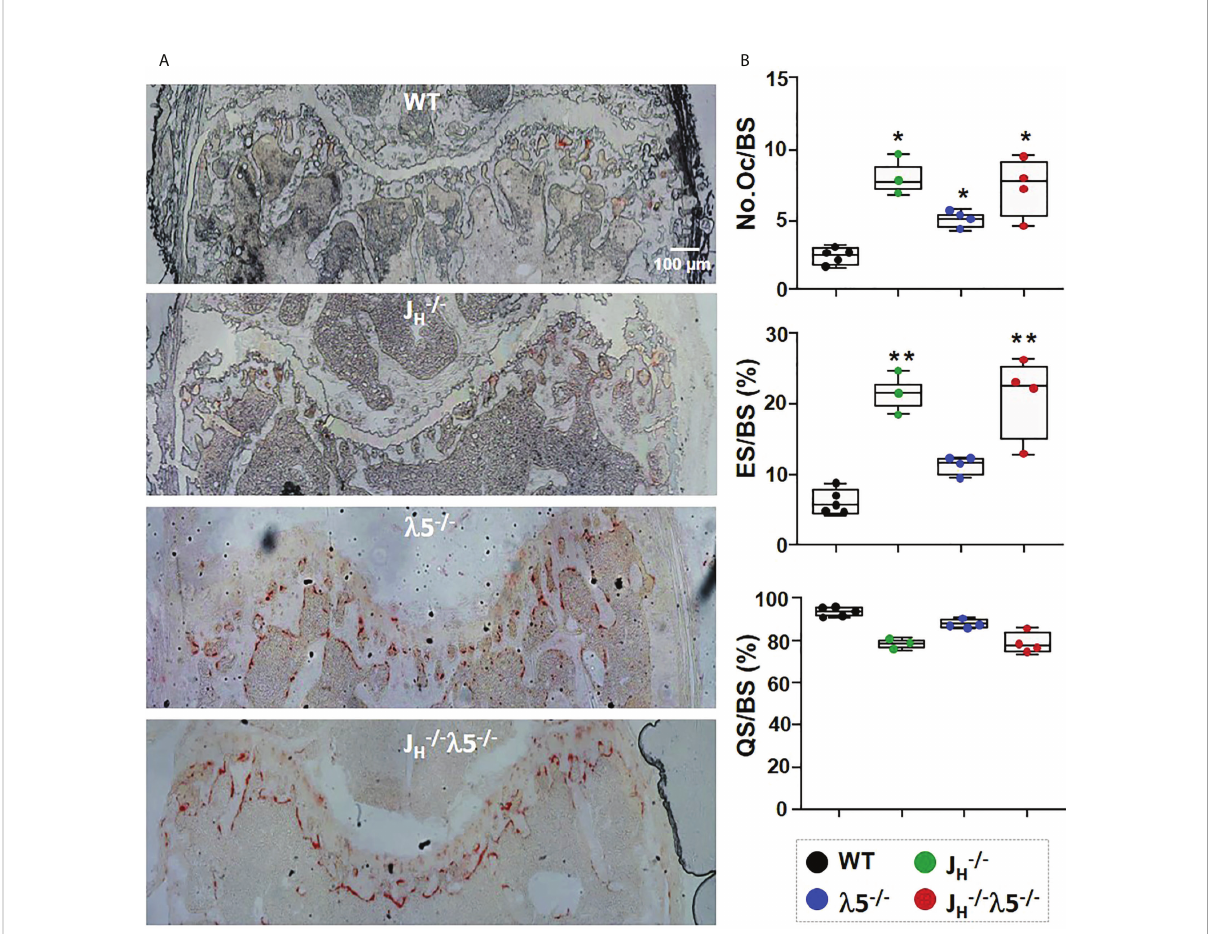
FIGURE 3 Increased numbers of osteoblasts and bone resorption upon loss of l 5 and/or post proB cells. (A) Representative images from six ‐ month old female femurs stained for TRAP activity. (B) Histomorphometric data pooled from n=3-5 mice per group show the average number of osteoclasts per bone surface (N.Oc/BS), erosion surface per bone surface (ES/BS) and the quiescent surface to bone surface (QS/BS). Statistical signi fi cance relative to WT mice was calculated by ANOVA. *p<0.05, **p<0.01. Scale bar: